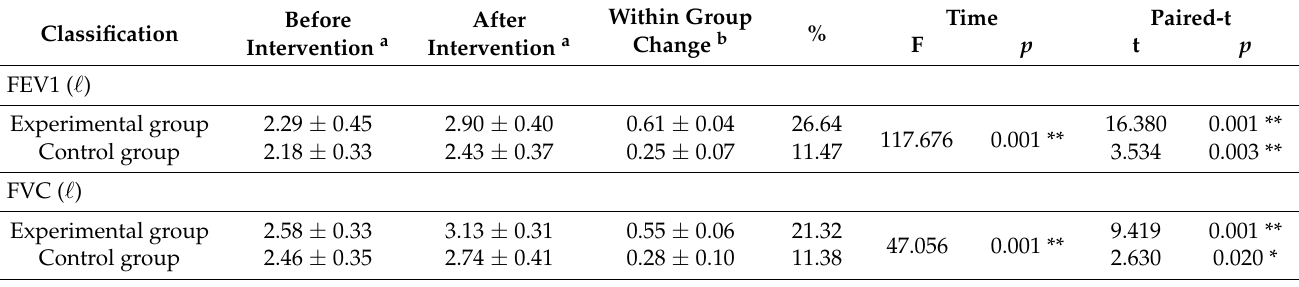
Table 5. Changes in respiratory function before and after intervention on two intervention